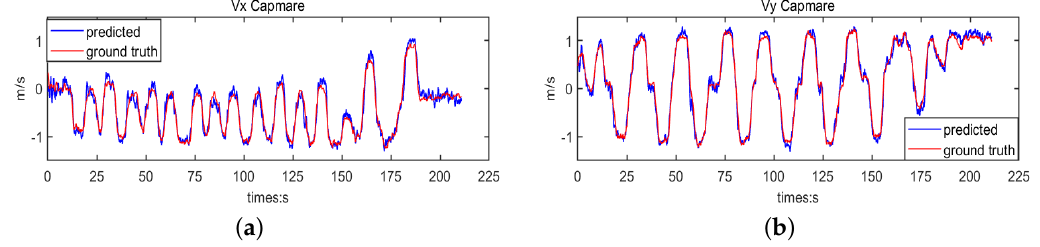
Figure 6. Velocity vector comparison. ( a ) (cid:101) v x versus v x , ( b ) (cid:101) v y versus v y .